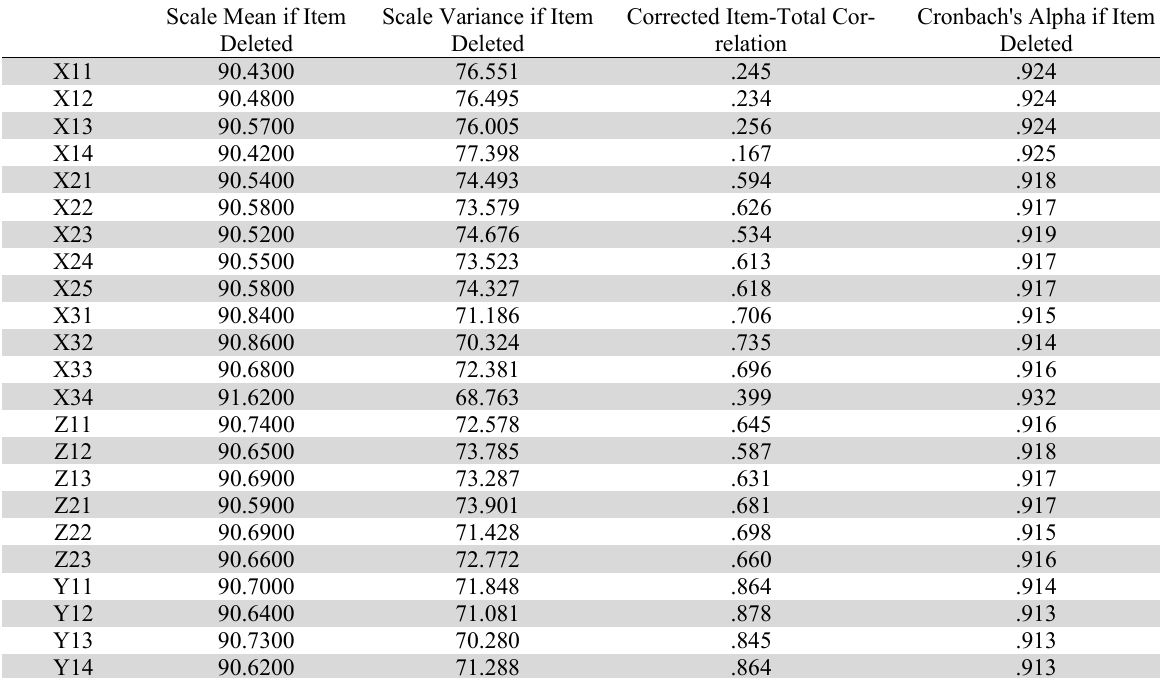
Cronbach's Alpha